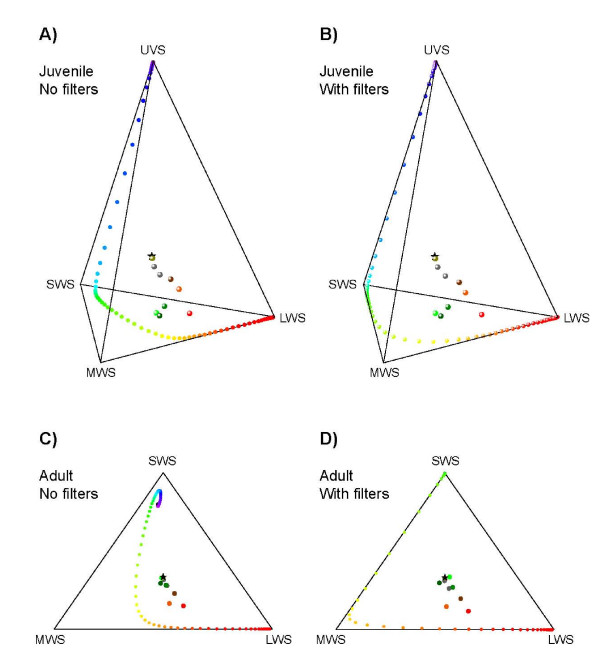
Chromaticity diagrams of lungfish cone photoreceptor colour space. Calculations were made for juvenile (A, B) and adult (C, D) lungfish, both with (A, C) and without (B, D) the filtering effects of the yellow ellipsoidal and red oil droplet spectral filters in the MWS and LWS cones. The black star in each diagram is the achromatic point. Large spheres/circles are the body colours (brown, orange, red), rocks and sand substrate (grey) and macrophytes (green) shown in Figs. 4B, C. Small circles represent monochromatic loci at 5nm intervals across the lungfish-visible spectrum. Note the increased separation of the object reflectance spectra and the displacement of the monochromatic loci towards the vertices in both juveniles (B) and adults (D) with spectral filters, relative to the situation without the effects of spectral filters. See Fig. 2 for explanation of abbreviations.